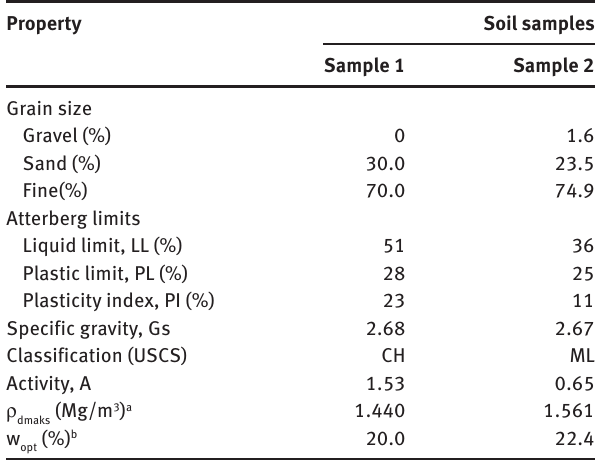
Table 1: Physical properties of the soils used in the study.